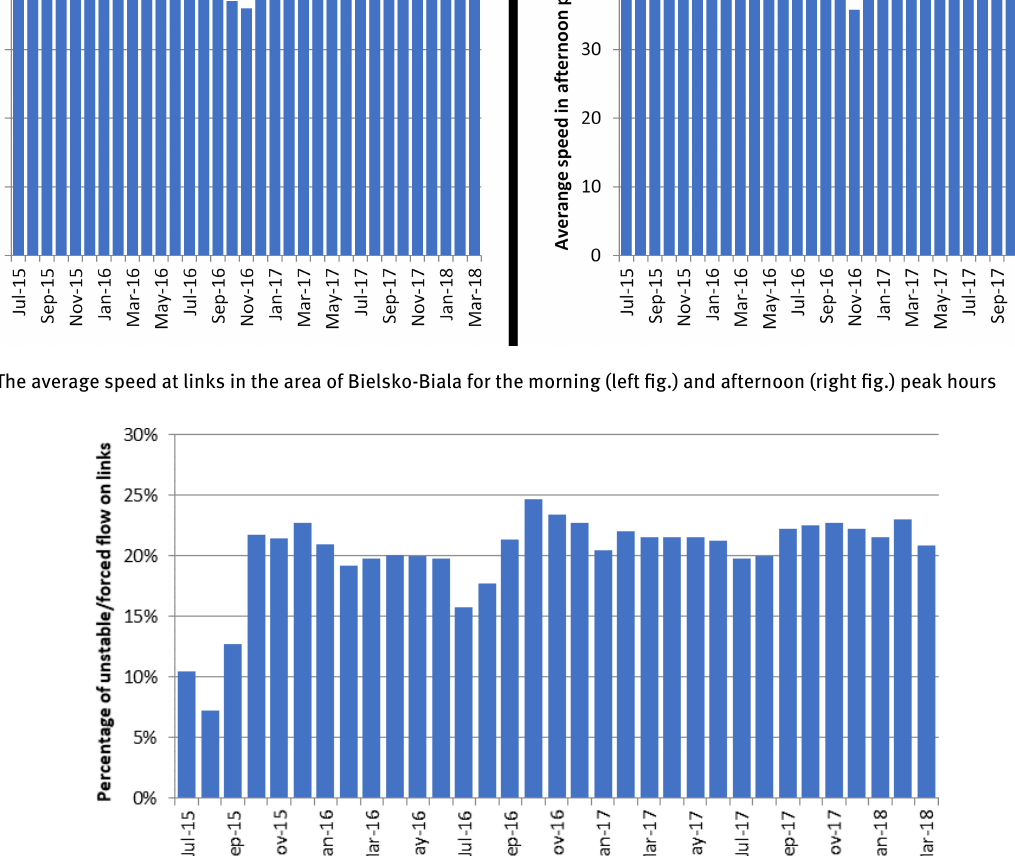
– Route 3: covers a part of the S1 road which is a ring road of the city, serving both urban and transit traffic towards the neighbouring cities (Zywiec and Cieszyn) and the surrounding